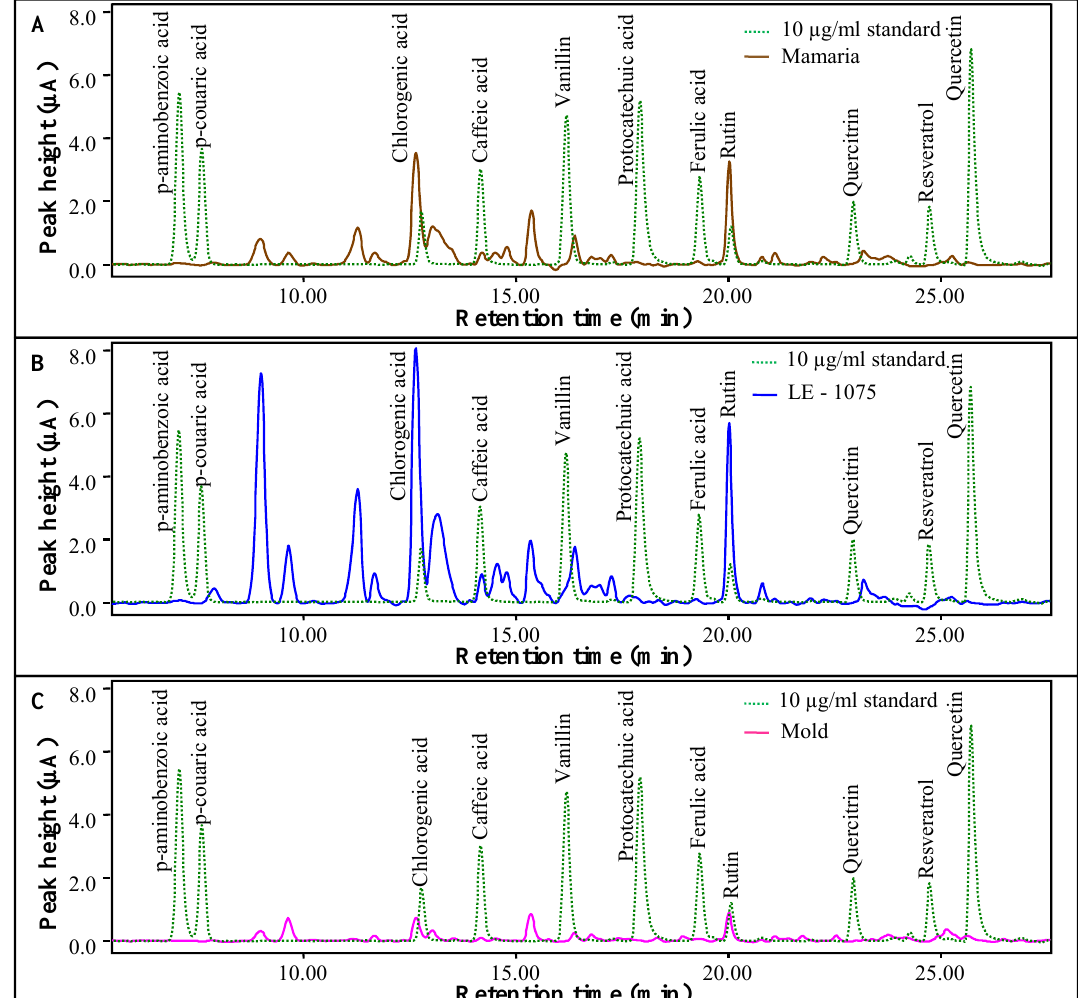
Figure 5. (a) Real chromatogram of Mamaria cultivar overlaid with standard mixture of analyzed polyphenols. (b) Real chromatogram of LE-1075 cultivar overlaid with standard mixture of analyzed polyphenols. (c) Real chromatogram of Mold cultivar overlaid with standard mixture of analyzed